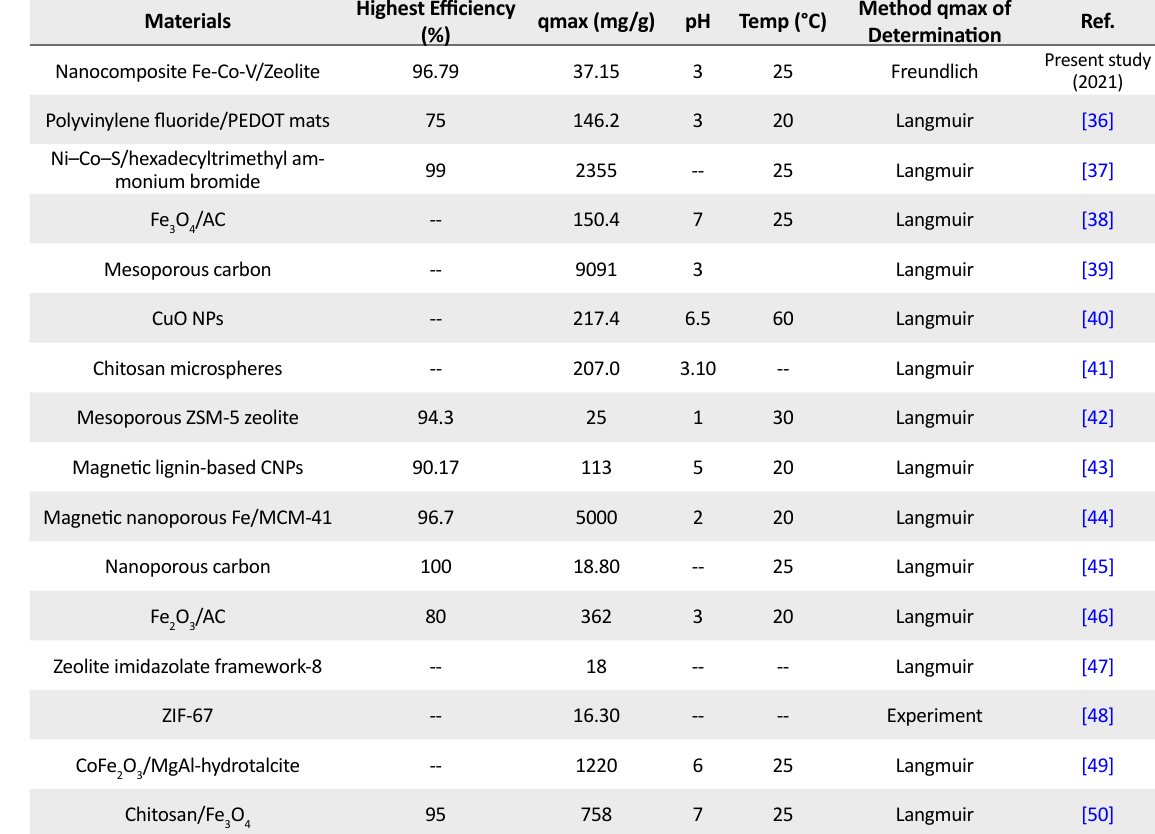
Table 3. Efficiency of methyl orange removal by other